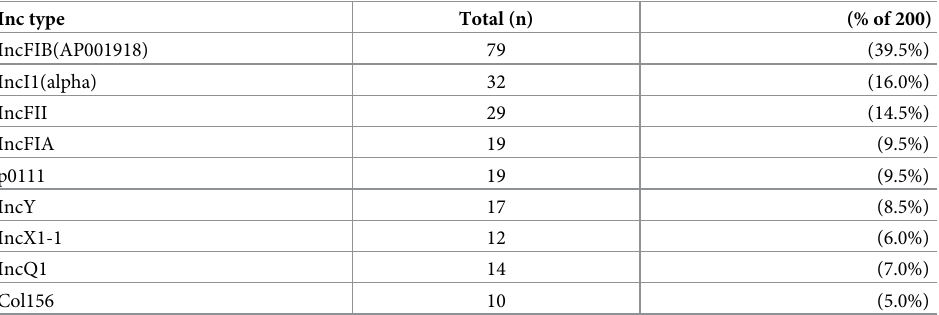
Table 3. Frequencies of plasmid incompatibility (Inc) types identified using whole-genome sequence data from phenotypically resistant Escherichia isolates obtained from wildlife, swine manure pits, and environmental sources in southern Ontario, Canada, 2011 − 2013 (n = 200).